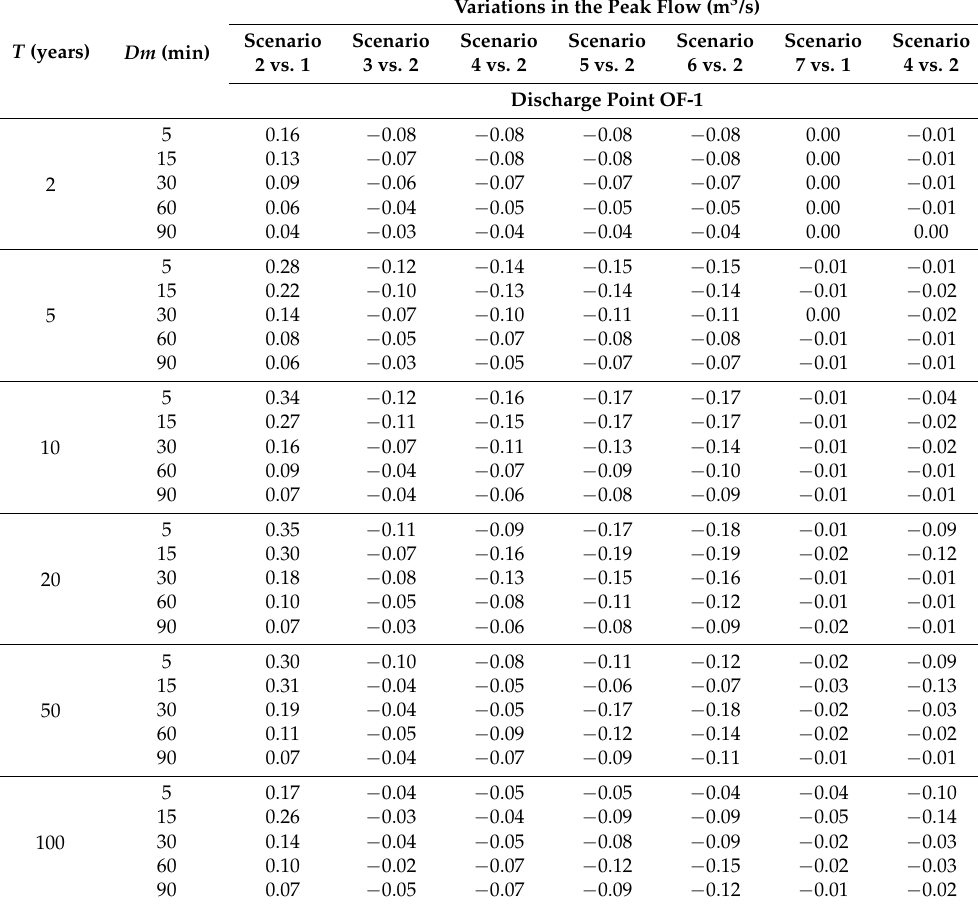
Table 6. Summary results with changes in the peak flow at the exit discharge point